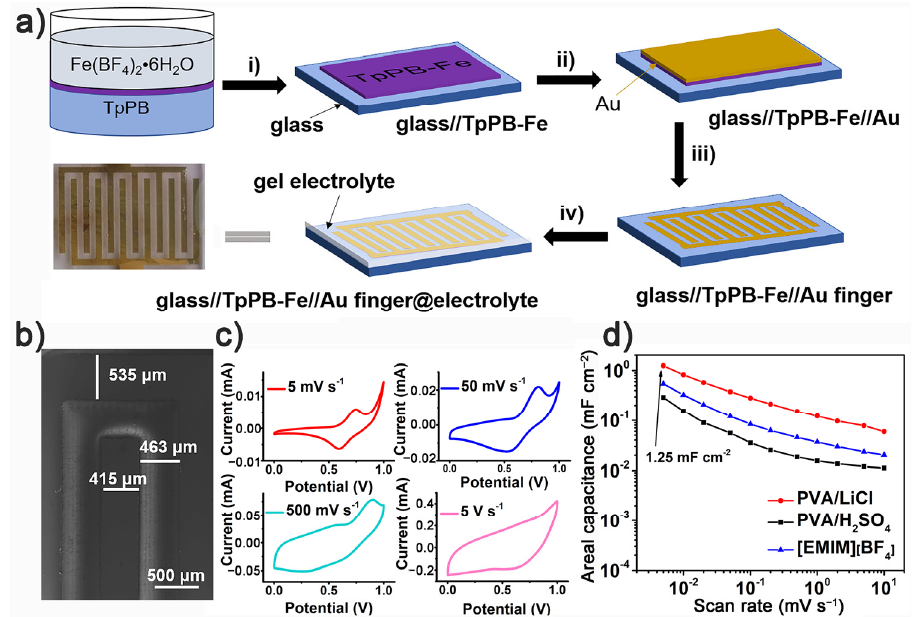
Figure 5. ( a ) Schematic illustration of TpPB-Fe films for on-chip MSCs on a silica substrate, i) transferring TpPB-Fe films onto the glass substrate, ii) sputtering an Au layer on TpPB-Fe film, iii) laser scraping TpPB-Fe//Au heterolayer into interdigital pattern, iv) drop-casting of gel electrolyte on interdigitated electrode; ( b ) The size information of cross finger electrode; ( c ) CV curves of TpPB-Fe-MSC with PVA/LiCl gel electrolyte at scan rates of 5, 50, 500, 5000 mV s − 1 ; ( d ) areal capacitance at scan rates from 5 to 10000 mV s − 1 with the electrolytes of PVA/LiCl (red), [EMIM][BF 4 ] electrolyte (blue) and PVA/H 2 SO 4 (black), respectively.